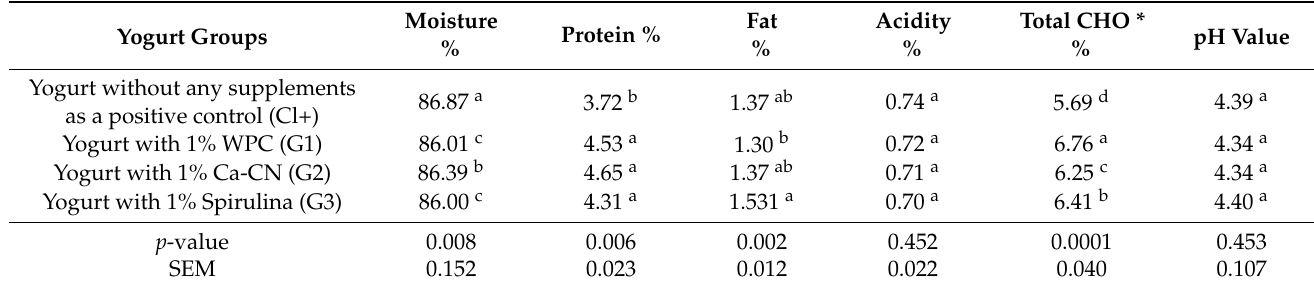
Table 3. Physicochemical properties of yogurt fortified with milk protein concentrates and Spirulina. Yogurt Groups